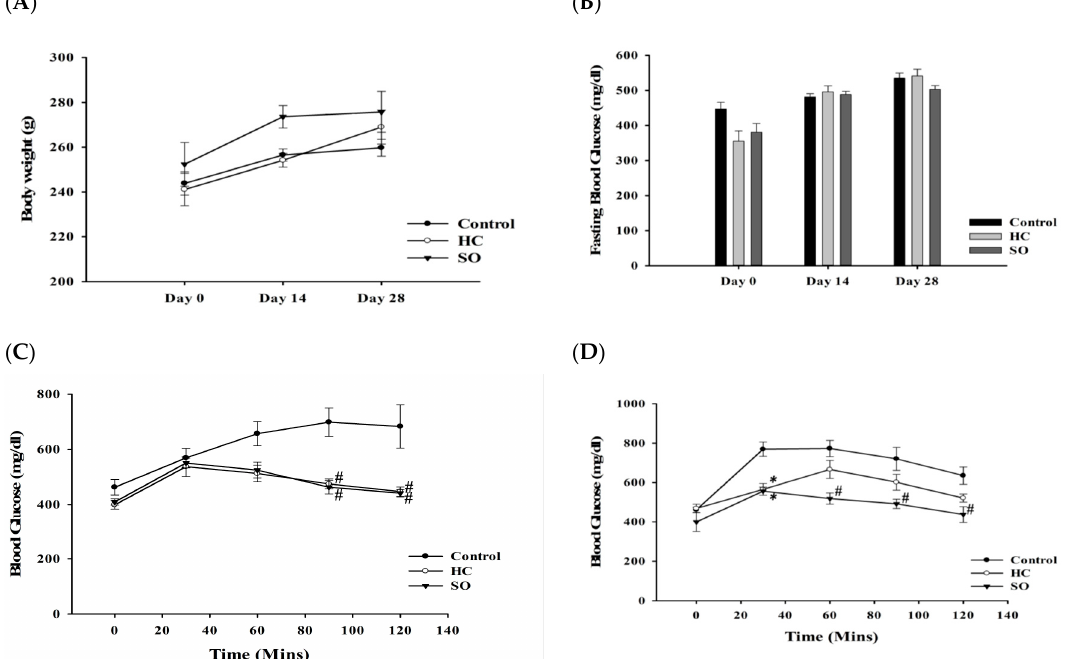
Figure 4. STZ-induced type 2 diabetes model (T2DM; N = 8) after the administration of HC and SO for 14 and 28 days. ( A ) Changes in body weight. ( B ) Changes in fasting blood glucose. ( C ) OGTT after administration of HC and SO for 14 days. ( D ) OGTT after administration of HC and SO for 28 days. Significant difference between control-treated group at * p < 0.05, # p < 0.01 by one-way ANOVA. Table 1. Area under the curve (AUC) of blood glucose in the oral glucose tolerance test (OGTT). AUC 14 Days 28 Days Sham 8898.75 ± 1816.12 1666.88 ± 3399.66 Control 23,578.13 ± 9636.76 32,130.00 ± 8133.19 H. coronarium leaves (HC) 11,730.00 ± 5959.70 14,979.38 ± 5656.03 * SugarOut (SO) 10,301.25 ± 5884.57 11,945.63 ± 13,782.89 **